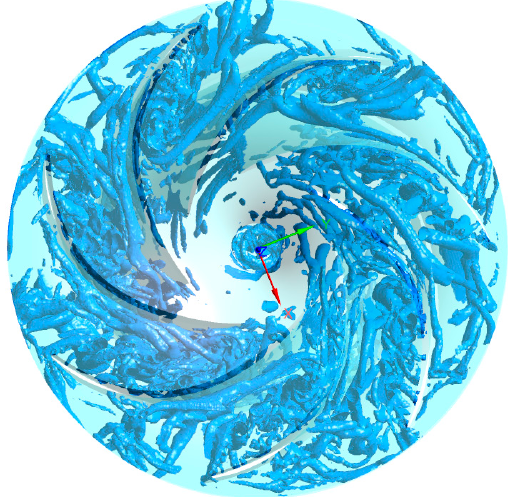
Figure 7 . Vortex structures at 25%Pn (10% characteristic scale).